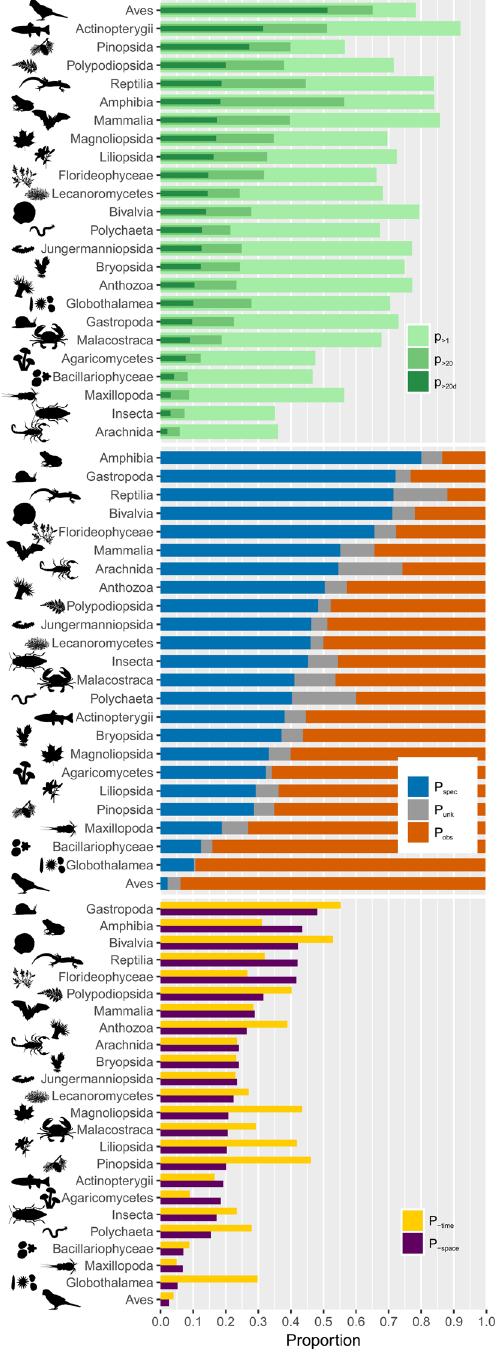
Figure 4. Taxonomic heterogeneity in sampling, occurrence data origin and quality for 24 taxonomic classes. Top : Proportion of species per class recorded in GBIF with at least one occurrence (light green: p > 1 ), with more than 20 occurrences (green: p > 20 ), and with more than 20 spatially distinct occurrences (i.e. “decently” sampled – dark green: p > 20d ). For all classes, except Aves, less than 1/3 of all species are “decently” sampled. Classes are ranked according to their proportion of “decently” sampled species. Middle : Occurrence origin ( basisOfRecord ) for each class. Some classes like Amphibia have a high proportion of occurrences based on specimens (blue: living or preserved specimen, material samples or fossils), whereas others like Aves have a majority of occurrences based on observation (orange: machine or human observation, literature). Grey bars show occurrences where the record basis is unknown. Classes are ranked according to their proportion of specimen- based occurrences. Bottom : Data incompleteness. Proportion of occurrences with spatial (purple) or temporal (yellow) inaccuracies for each class. Spatial inaccuracy corresponds to an occurrence lacking coordinates or tagged has having geospatial issues by GBIF. Temporal inaccuracy corresponds to a sampling event with no specified month or year. Classes are ranked according to their proportion of occurrences with spatial